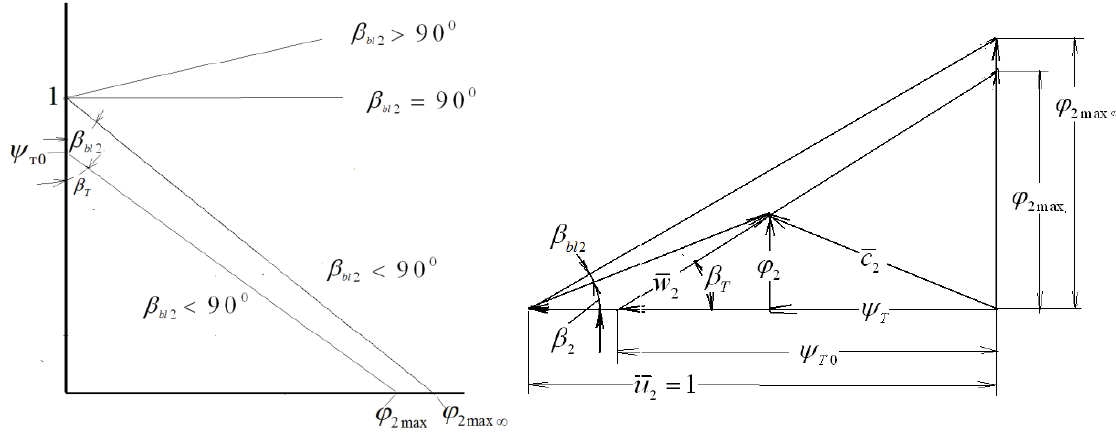
Figure 6. Loading factor performance and velocity triangle with linear dependence ψ T = f ( ϕ 2 )